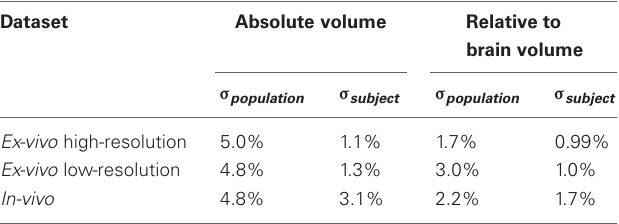
FIGURE 3 | A scatter plot showing the correlation between hippocampal and total brain volume from fixed-brain specimens. Regression line and its 95% confidence interval are superimposed.